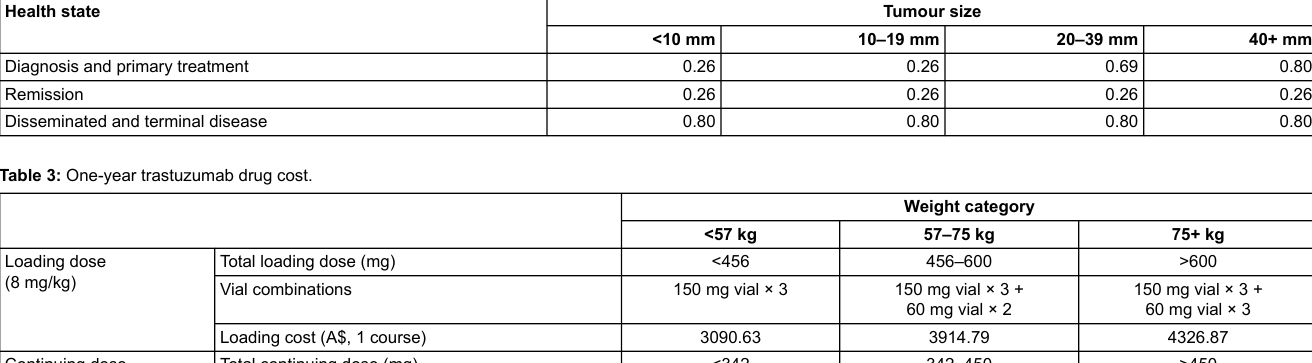
Table 2: Breast cancer disability weights by tumour size and health state [24].